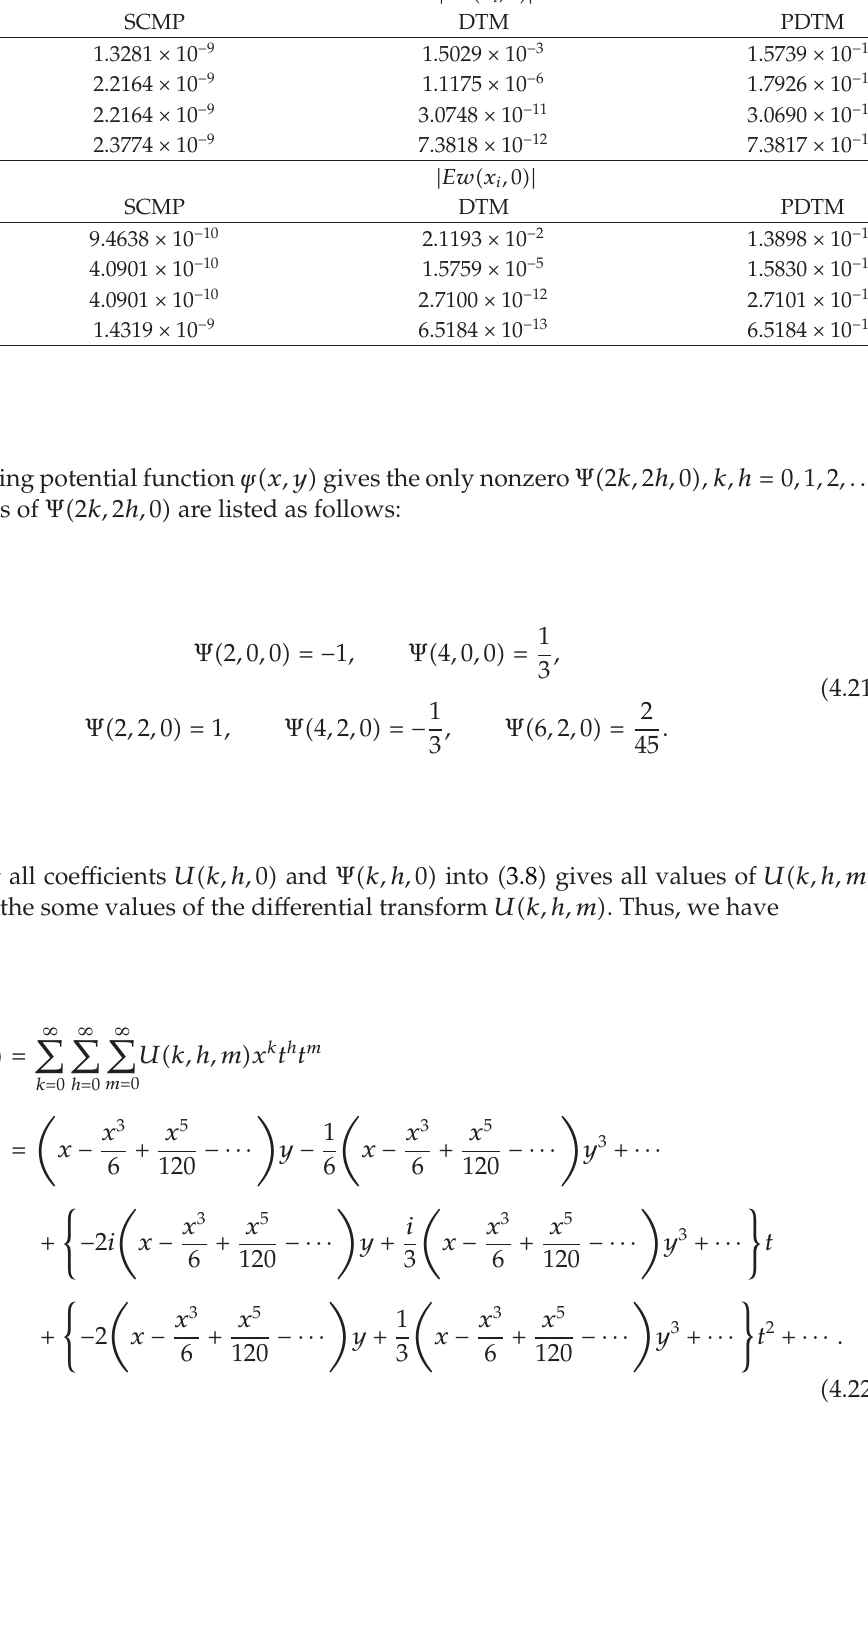
Table 4: Comparison for the absolute errors | Ev | and | Ew | of the approximate solutions obtained by SCMP, DTM, and PDTM at various test point x i with fixed time t (cid:7) 1.